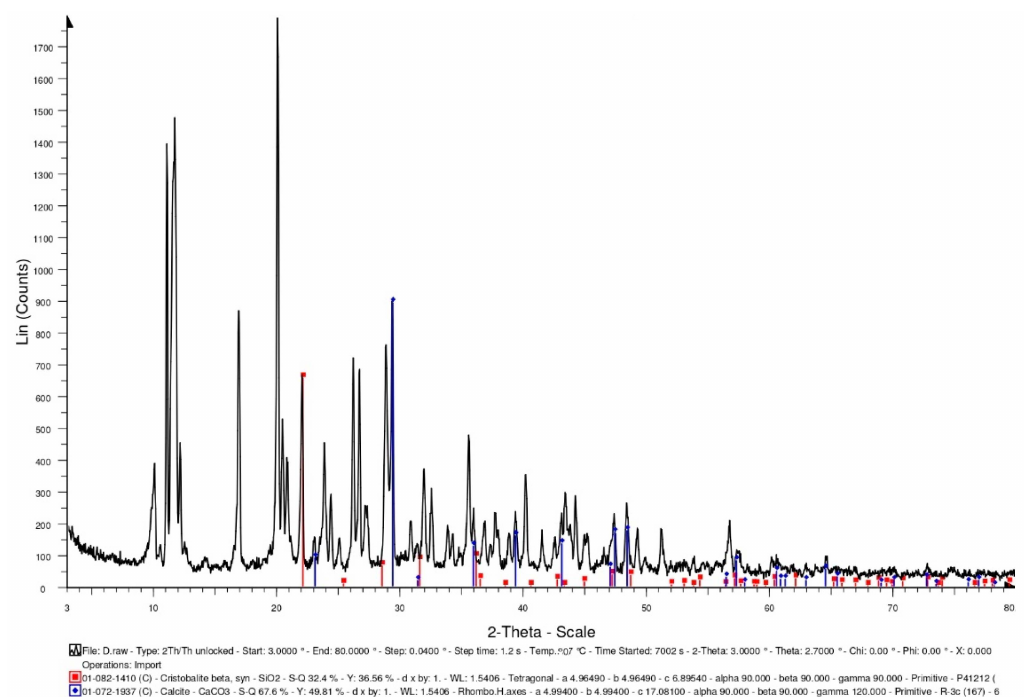
Figure 8. XRD-analysis results of the bacteria powders not subjected to high